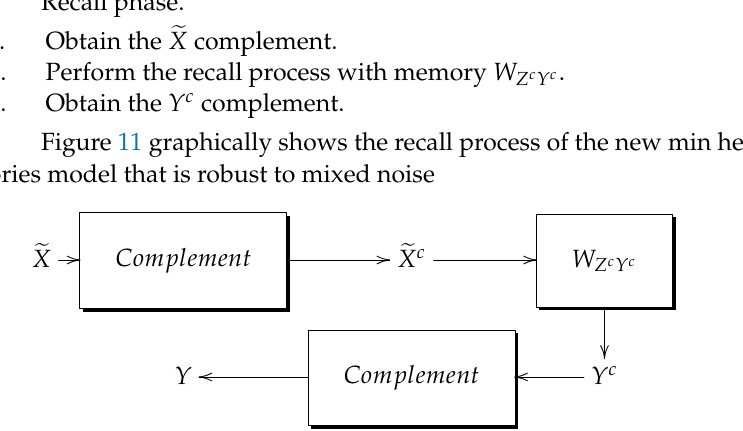
Figure 11. Recall process of the new model of min heteroassociative